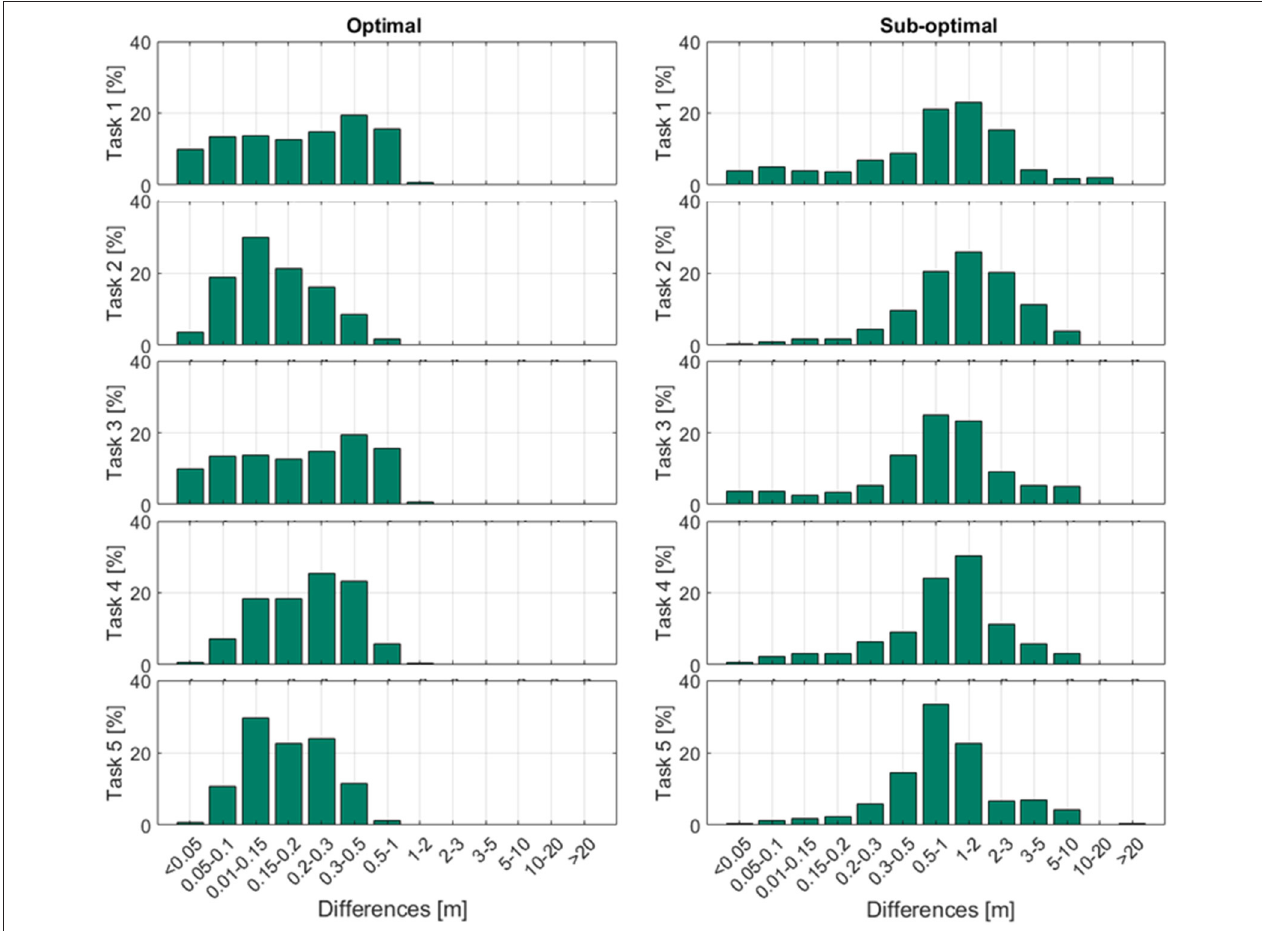
FIGURE 3 | Distance differences for each task compared to the reference system. The differences were assigned to accuracy categories, and expressed as percentages of the total number of raw data